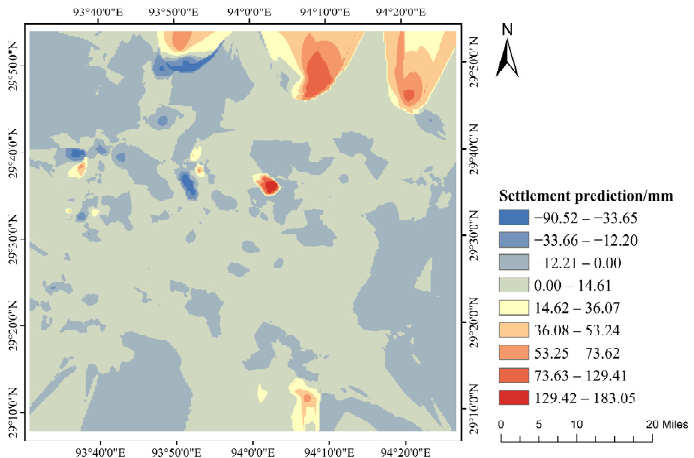
Figure 17. Predicted results of surface deformation in the study area.